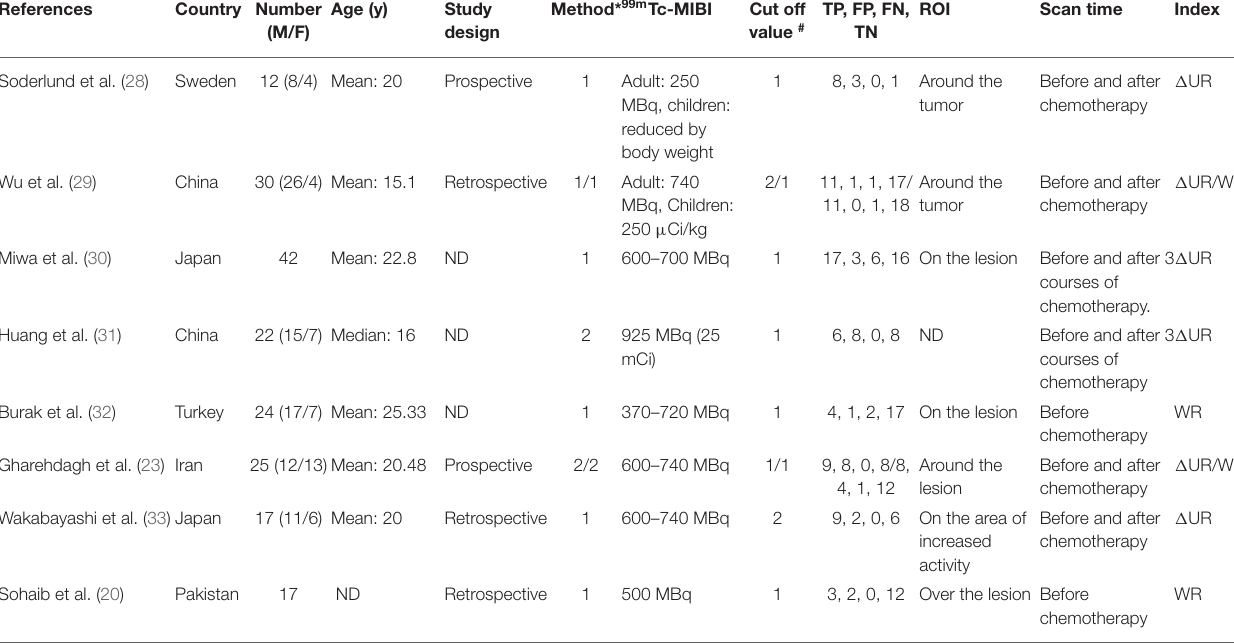
TABLE 1 | Main characteristics of the studies included in this meta-analysis.